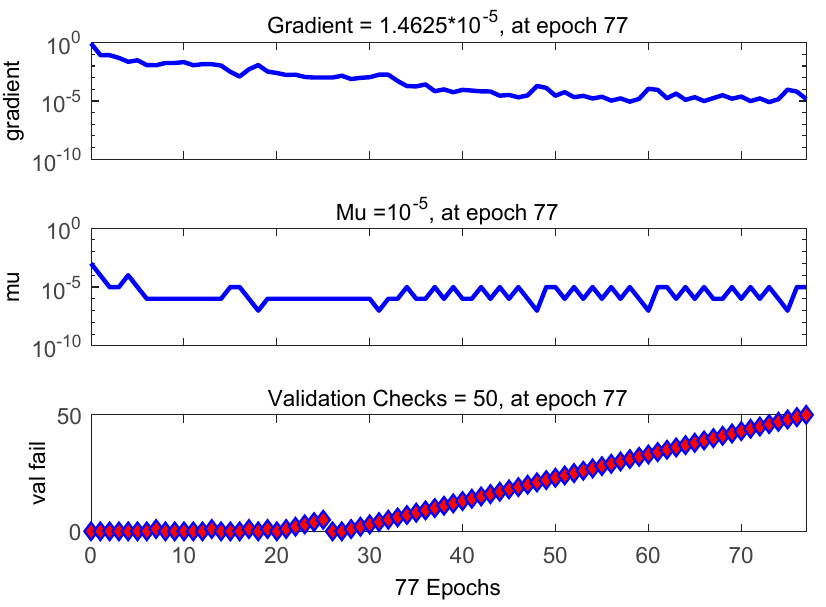
Figure 11. Training state of the BP neural network.